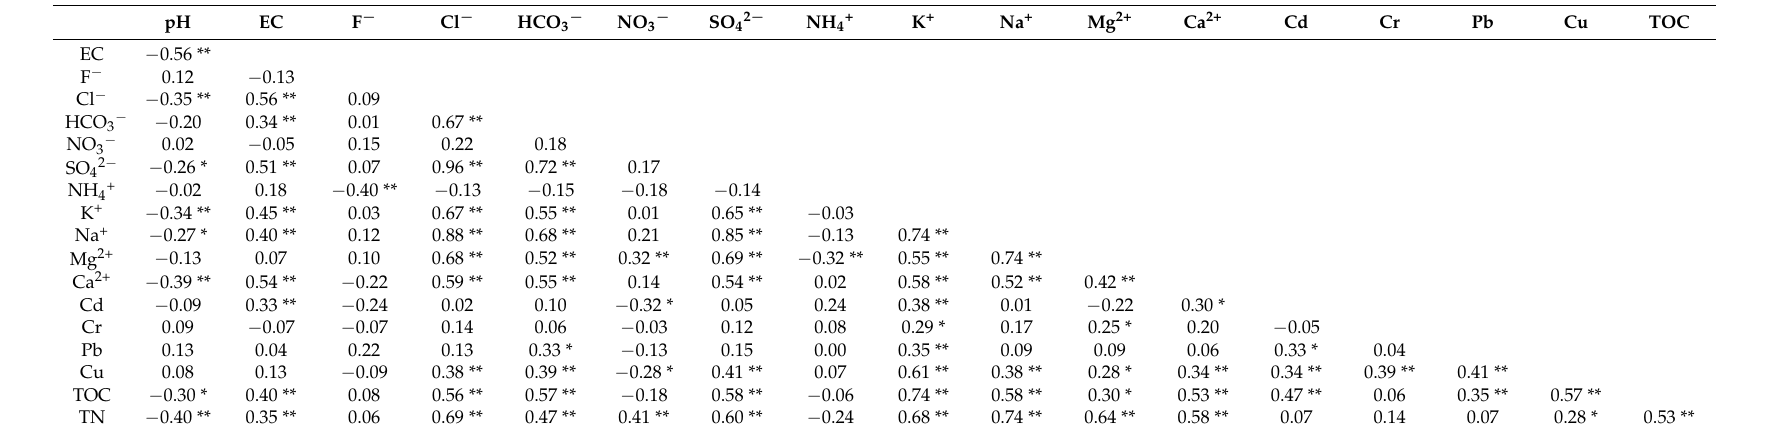
Table 6. Correlation Coefficient of MEs for SW in the five major cities, NW,